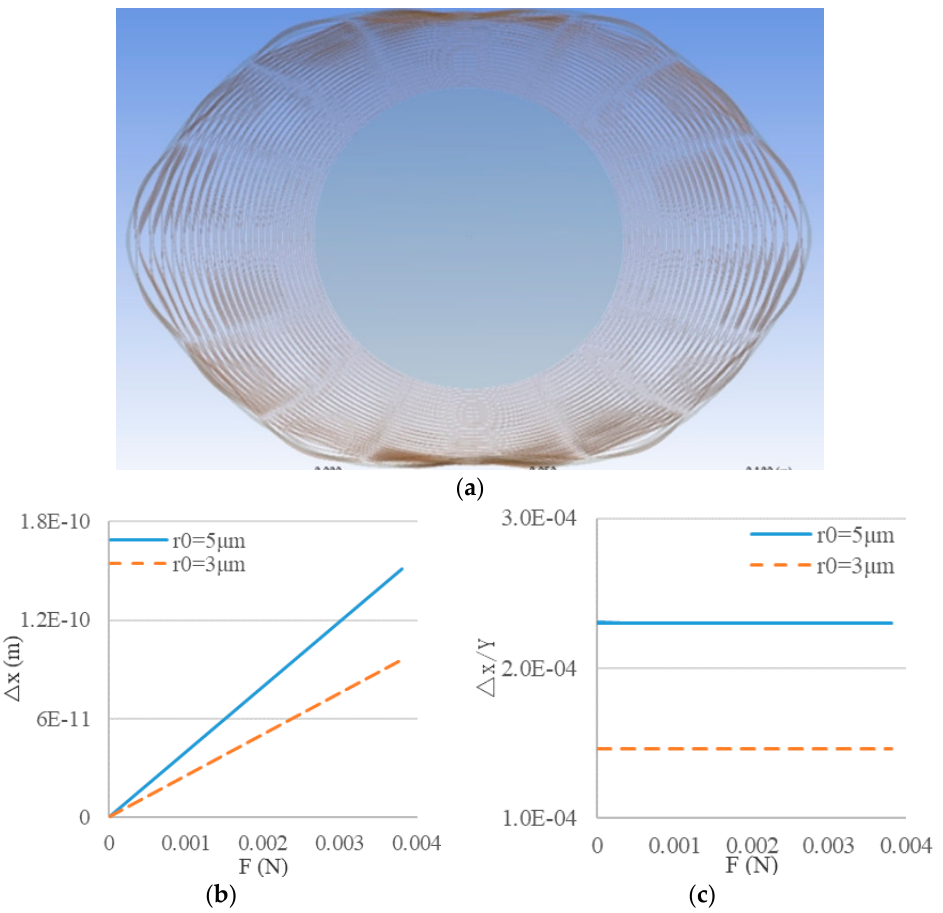
Figure 9. ( a ) Deformation of the MEMS disk resonator under static force; ( b ) Radius variation of the optical resonator; ( c ) Ratios of radii variation in optical and MEMS resonators.